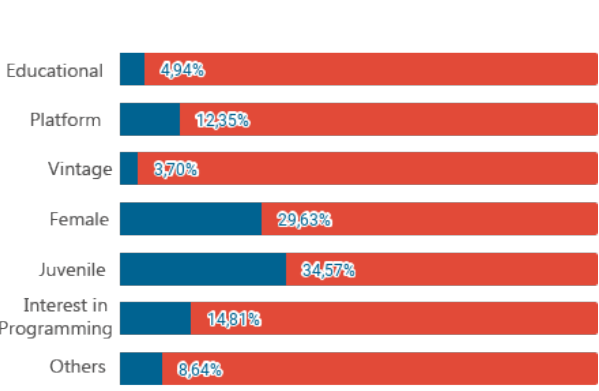
Figure 22. If so, what audience do you think it is intended for? - Test 2.